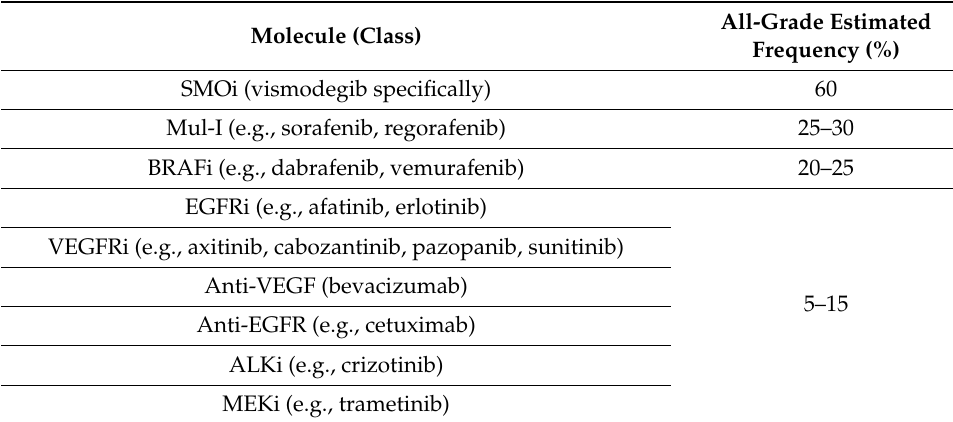
Table 4. Main * targeted therapy classes used against solid tumors and their corresponding risk of alopecia (adapted from references